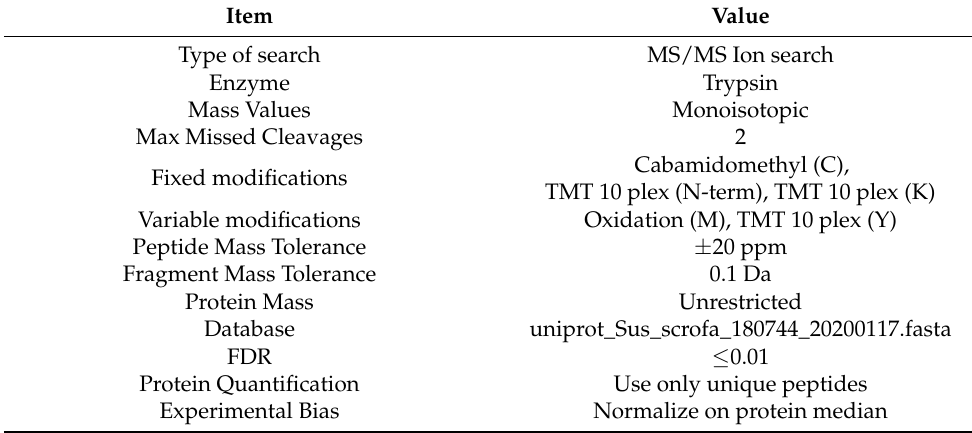
Table 1. Protein samples retrieved; qualitative and quantitative parameters. Item Value Type of search MS/MS Ion search Enzyme Mass